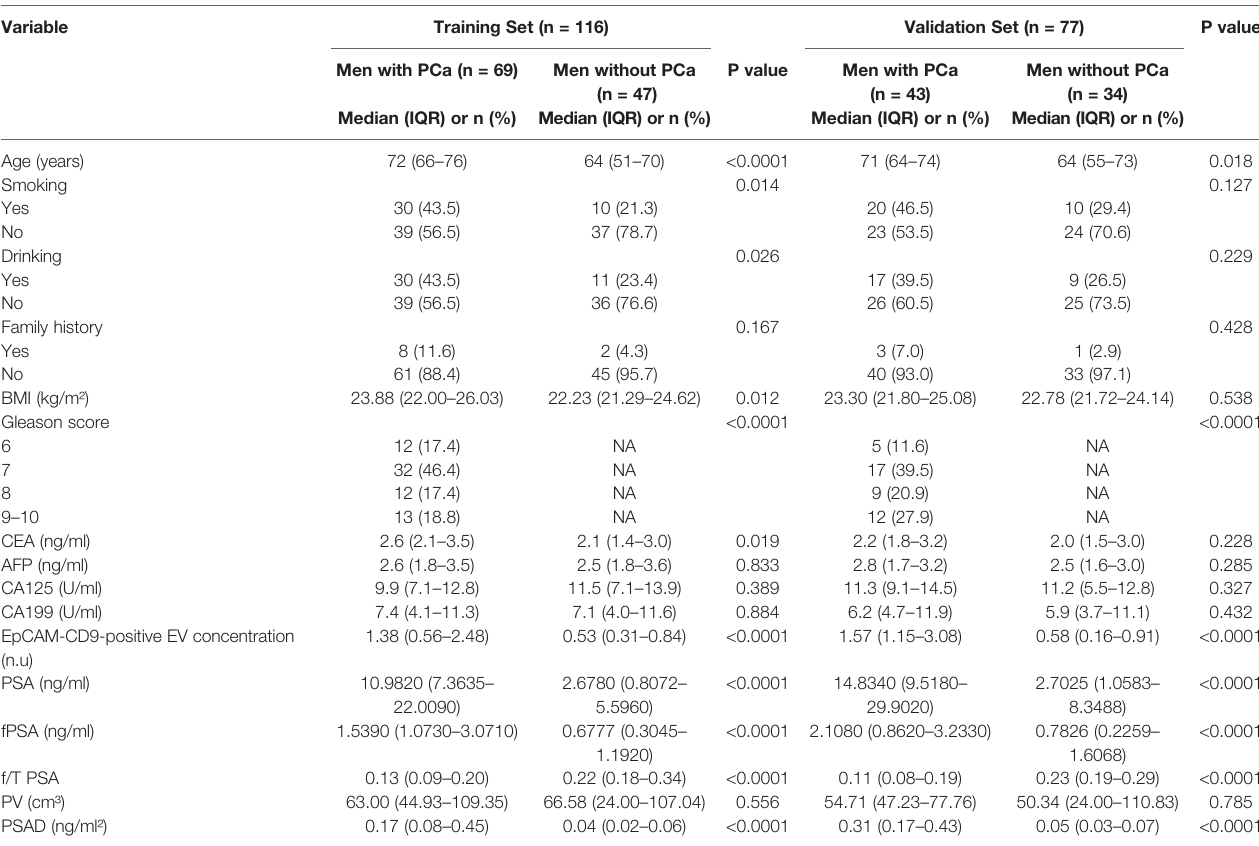
TABLE 1 | Baseline characteristics of the training and validation